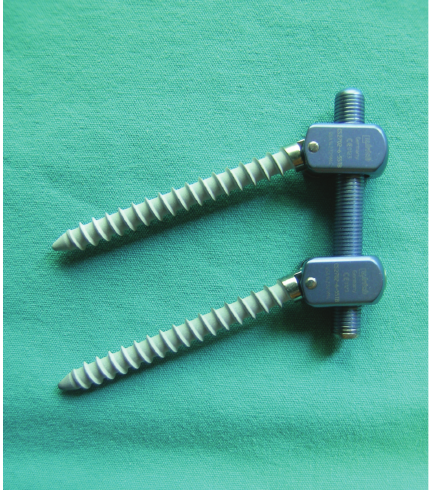
Figure 10: The Cosmic posterior dynamic